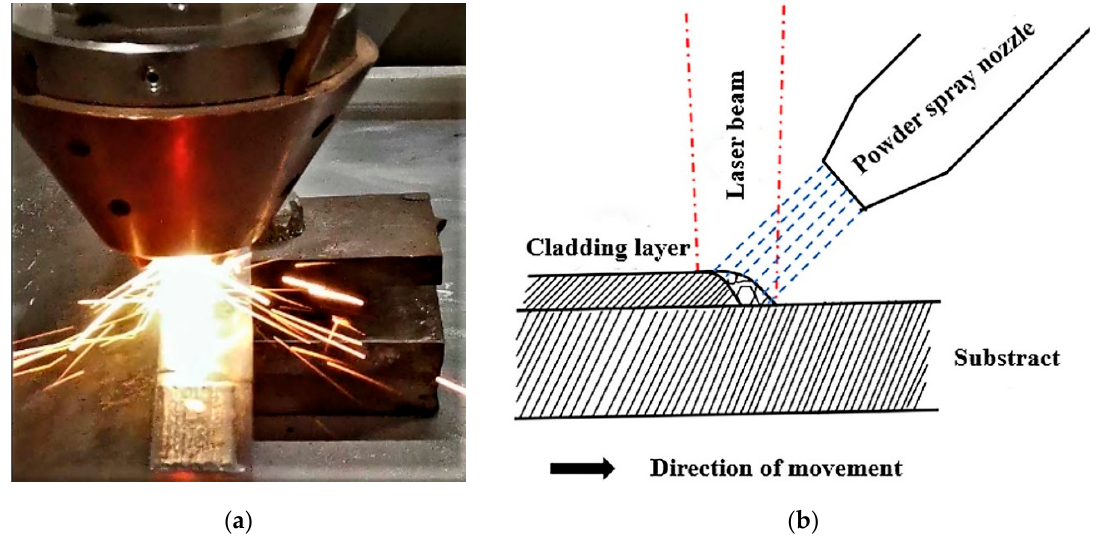
Figure 2. ( a ) Laser cladding test; ( b ) schematic diagram of coaxial powder delivery for laser cladding.